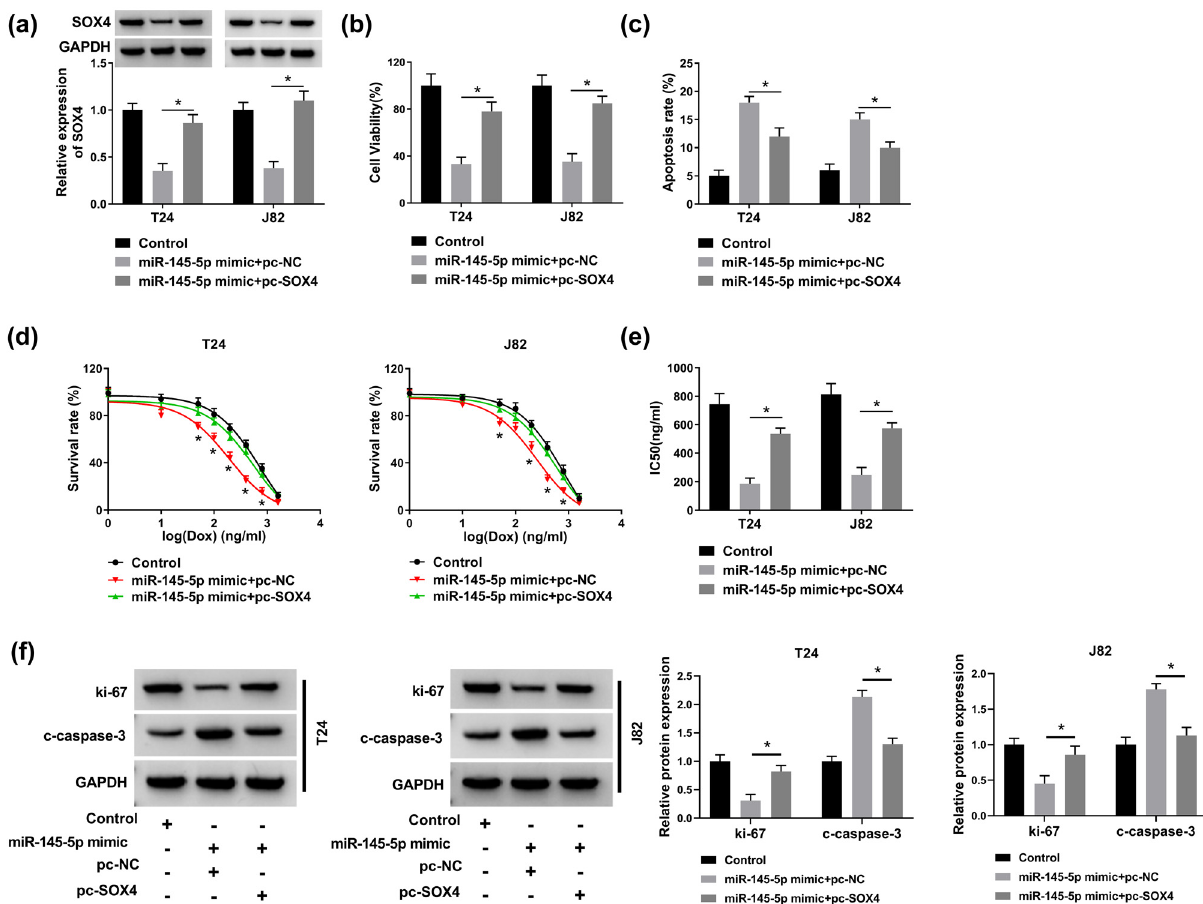
Figure 6: Overexpression of SOX4 weakened the e ff ect of miR - 145 - 5p on bladder cancer cells. ( a – f ) T24 and J82 cells were transfected with miR - 145 - 5p mimic + pc - NC or miR - 145 - 5p mimic + pc - SOX2, respectively. ( a ) The protein level of SOX4 was determined western blot after co - transfection with miR - 145 - 5p mimic and pc - NC or pc - SOX4. ( b ) CCK8 assay was performed to detect cell viability. ( c ) Cell apoptosis rate was detected by fl ow cytometry analysis. ( d ) T24 and J82 cells were incubated with di ff erent concentrations of doxorubicin and cell survival rate was determined by fl ow cytometry analysis. ( e ) The IC 50 values of cells treated with doxorubicin. ( f ) The protein levels of c - caspase - 3 and ki - 67 in the transfected cells were determined by western blot. * P <